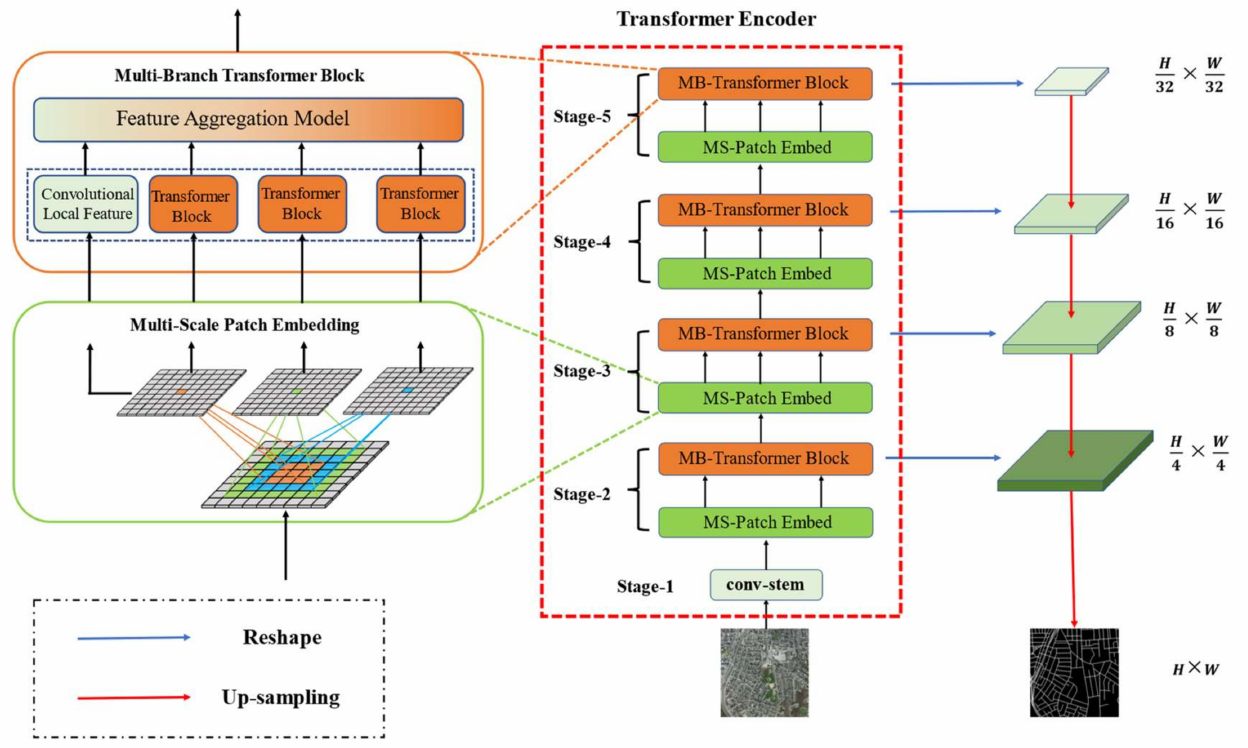
Figure 3. The overall structure of